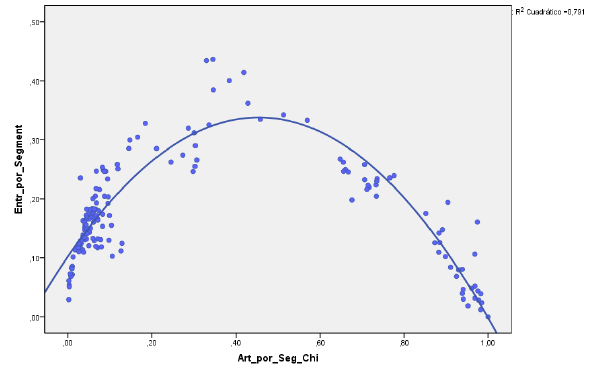
Figure 7.Spatial Distribution of the Urban Entropy of the Artificialized Land of Chicago according to the distance to